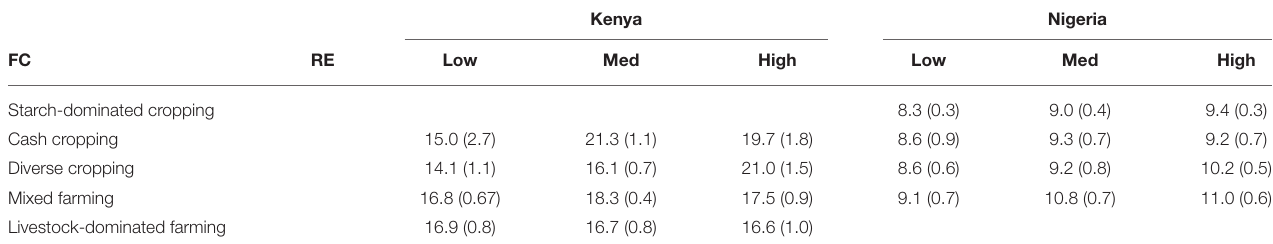
TABLE 4 | Mean total farmed species richness (and standard errors in parentheses) of farms in each RE × FC combination in each